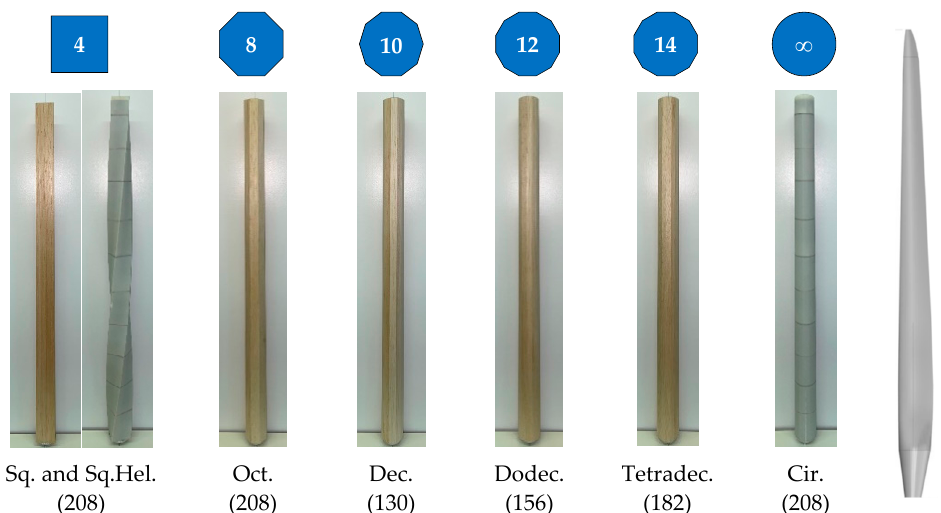
Figure 1. Polygonal cross-sectional towers and blade (LM-Glasfiber) used in the present study (the numbers in parentheses are the number of pressure taps on the towers).